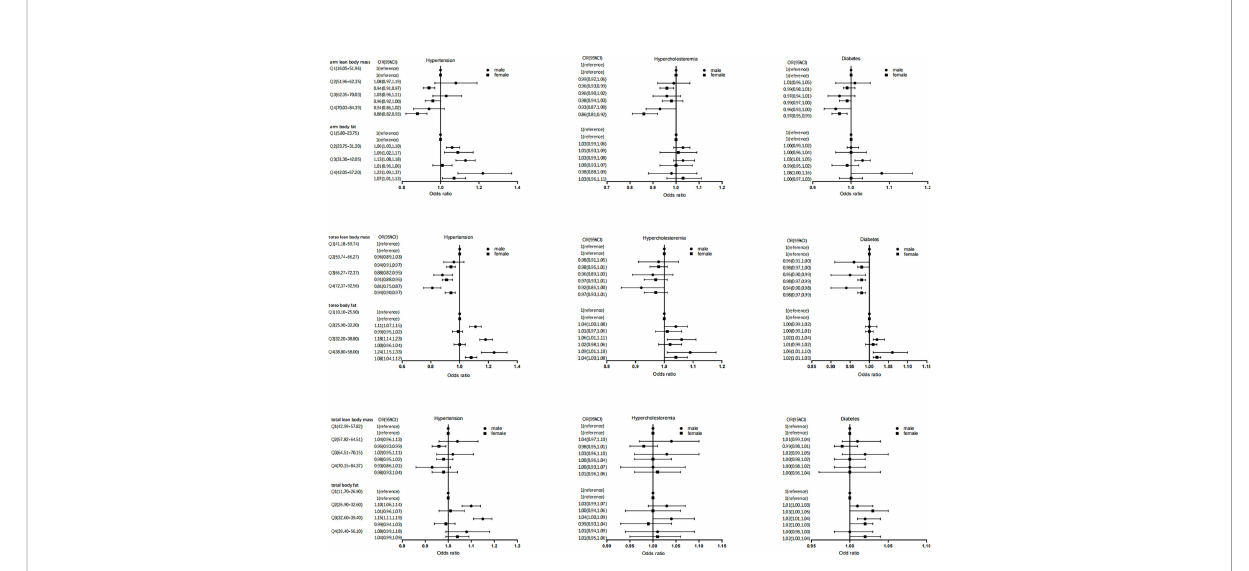
FIGURE 3 Association of segmental body composition with metabolic disease, at different